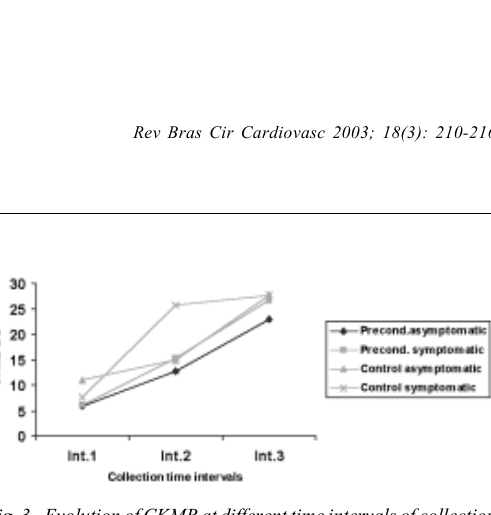
Fig. 3 - Evolution of CKMB at different time intervals of collection for the different groups Int. 1 – Initiation of cardiopulmonary bypass Int. 2 – After the first anastomosis